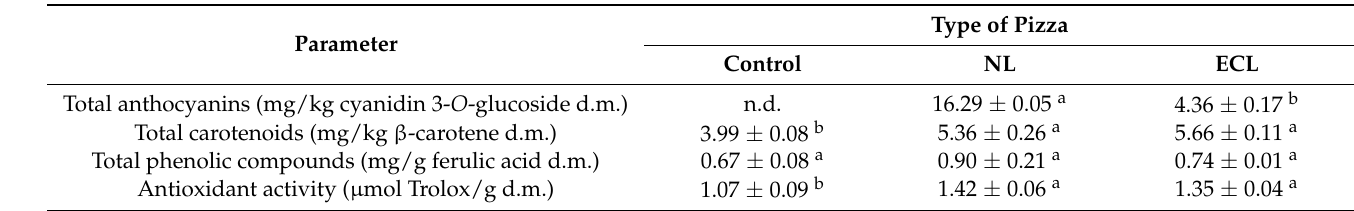
Table 6. Level of bioactive compounds and antioxidant activity of the experimental GF pizza samples. NL = native lentil flour; ECL = extruded-cooked lentil flour.